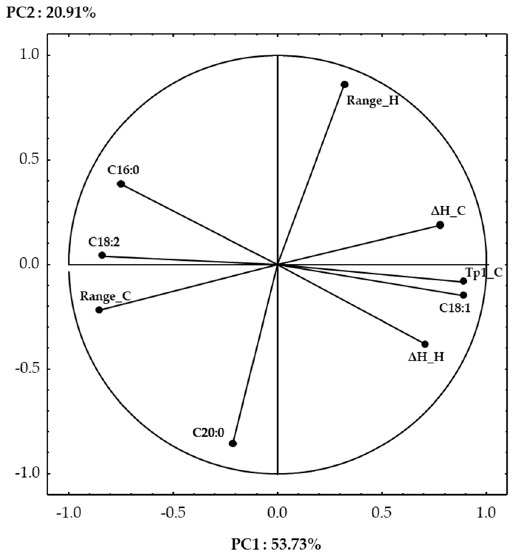
Figure 4. Projections of the variables on a factor plane.